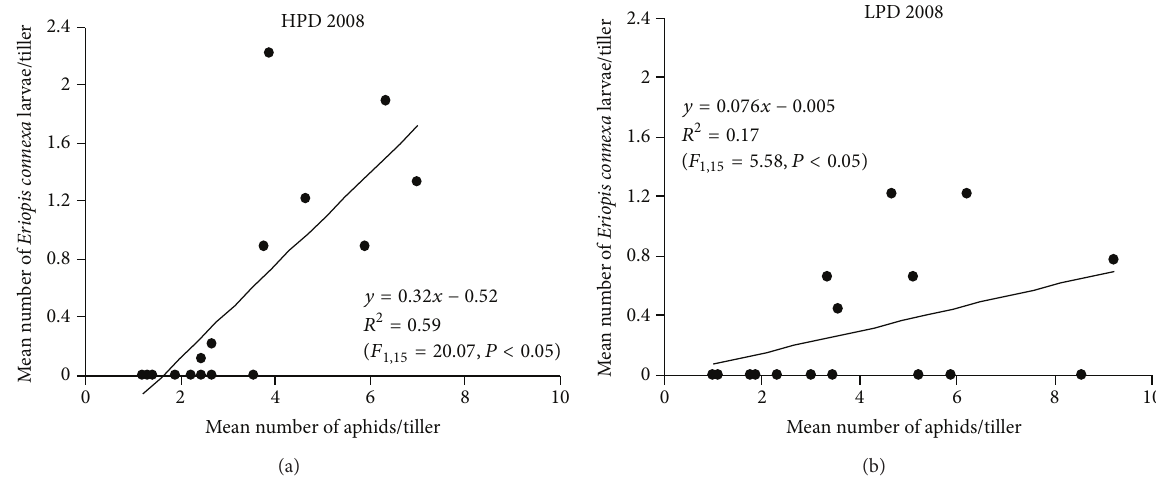
Figure 5: Reproductive numerical response of Eriopis connexa larvae to variation in cereal aphid abundance in wheat crops with a high (HPD) and low plant diversity (LPD). Balcarce,